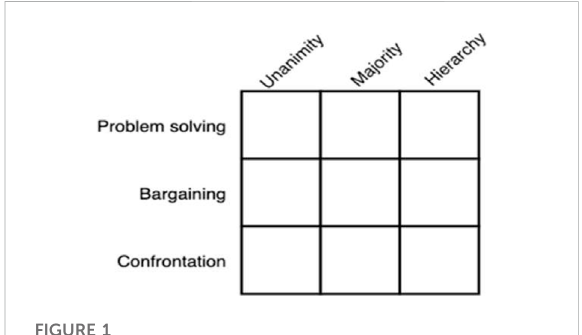
FIGURE 1 Decision-style framework (Scharpf, 1988a).